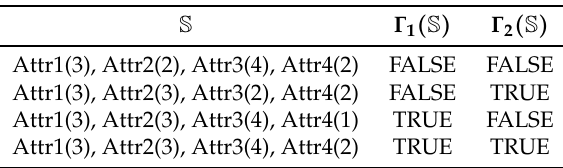
Table 1. Valuation of the weighted access trees in Figure